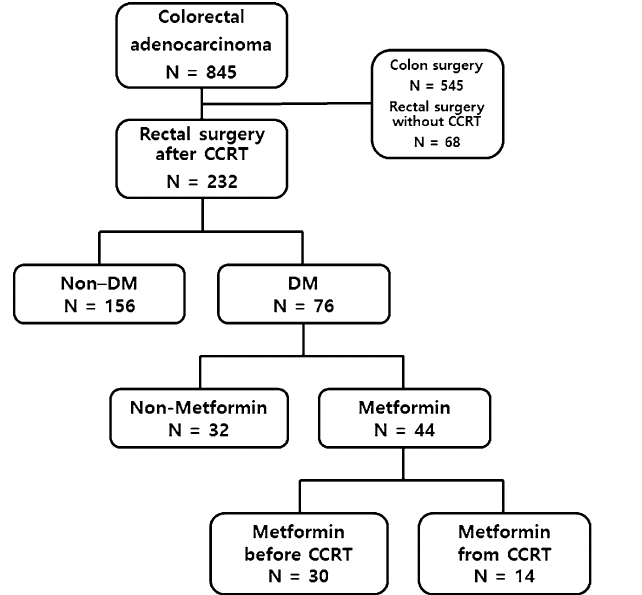
Figure 1. Flow chart of patient